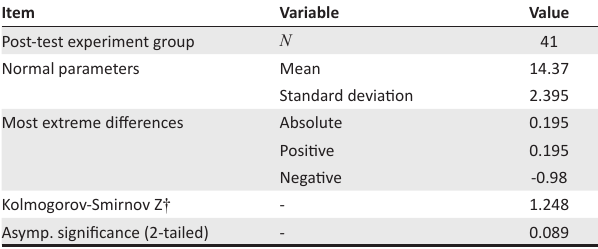
TABLE 4: One-sample Kolmogorov-Smirnov Test.